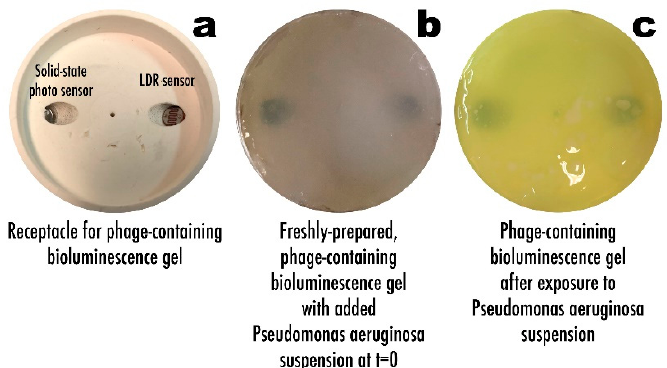
Figure 11. Receptacle for the bio-reactive hydrogel in bio-detection system II, showing the position of the two light sensors ( a ), macroscopic aspect of the freshly-prepared phage-containing bio-reactive hydrogel ( b ), and macroscopic aspect of the phage-containing bio-reactive hydrogel with produced bioluminescence following exposure to P. aeruginosa cells ( c ).